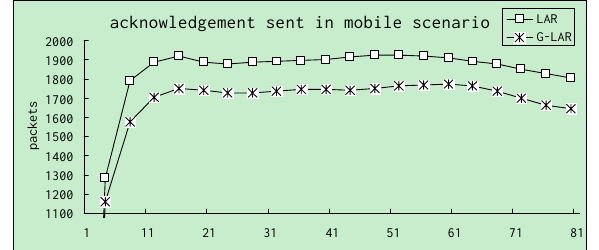
Fig. 8. Routing traffic sent in mobile scenario